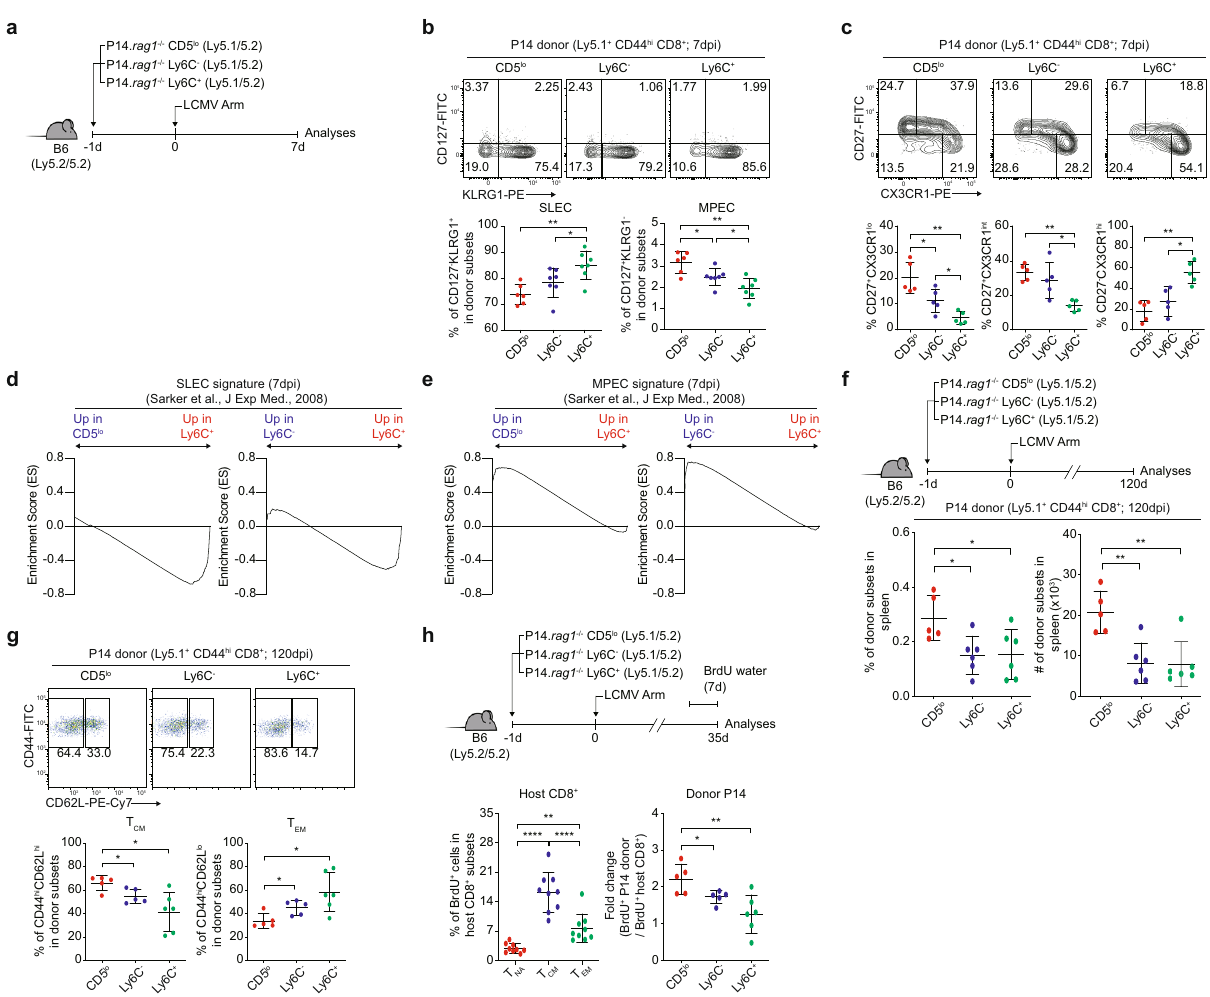
Fig. 6 CD5 lo , Ly6C − , and Ly6C + cells exhibit distinct effector fates upon LCMV infection. a Experimental scheme of ( b – f) . b Percentage of CD127 − KLRG1 + and CD127 + KLRG1 − P14 CD44 hi donor cells ( n = 6 mice for CD5 lo , n = 7 mice for Ly6C − and Ly6C + ). c Percentage of CD27 + CX3CR1 lo , CD27 + CX3CR1 int , and CD27 − CX3CR1 hi P14 CD44 hi donor cells ( n = 5 mice for each group). d , e GSEA pro fi les of SLEC ( d ) and MPEC ( e ) signature genes between P14 CD5 lo and P14 Ly6C + donor cells or P14 Ly6C − and P14 Ly6C + donor cells. f Percentage and donor recovery of P14 CD44 hi donor cells at 120 dpi ( n = 5 mice for CD5 lo , n = 6 mice for Ly6C − and Ly6C + ). g Percentage of CD44 hi CD62L hi and CD44 hi CD62L lo P14 donor cells at 120 dpi ( n = 5 mice for CD5 lo and Ly6C − , n = 6 mice for Ly6C + ). h Percentage of P14 CD44 hi BrdU + donor cells at 35 dpi ( n = 9 mice for T NA , T CM , and T EM , n = 5 mice for CD5 lo , n = 6 mice for Ly6C − and Ly6C + ). Data are accumulated values of at least two independent experiments ( b – i ). Statistical signi fi cance was con fi rmed by two-tailed unpaired Student ’ s t -test. Results are shown as mean ± SD. Data representative of 2 – 3 independent experiments. Source data are provided as a Source data fi